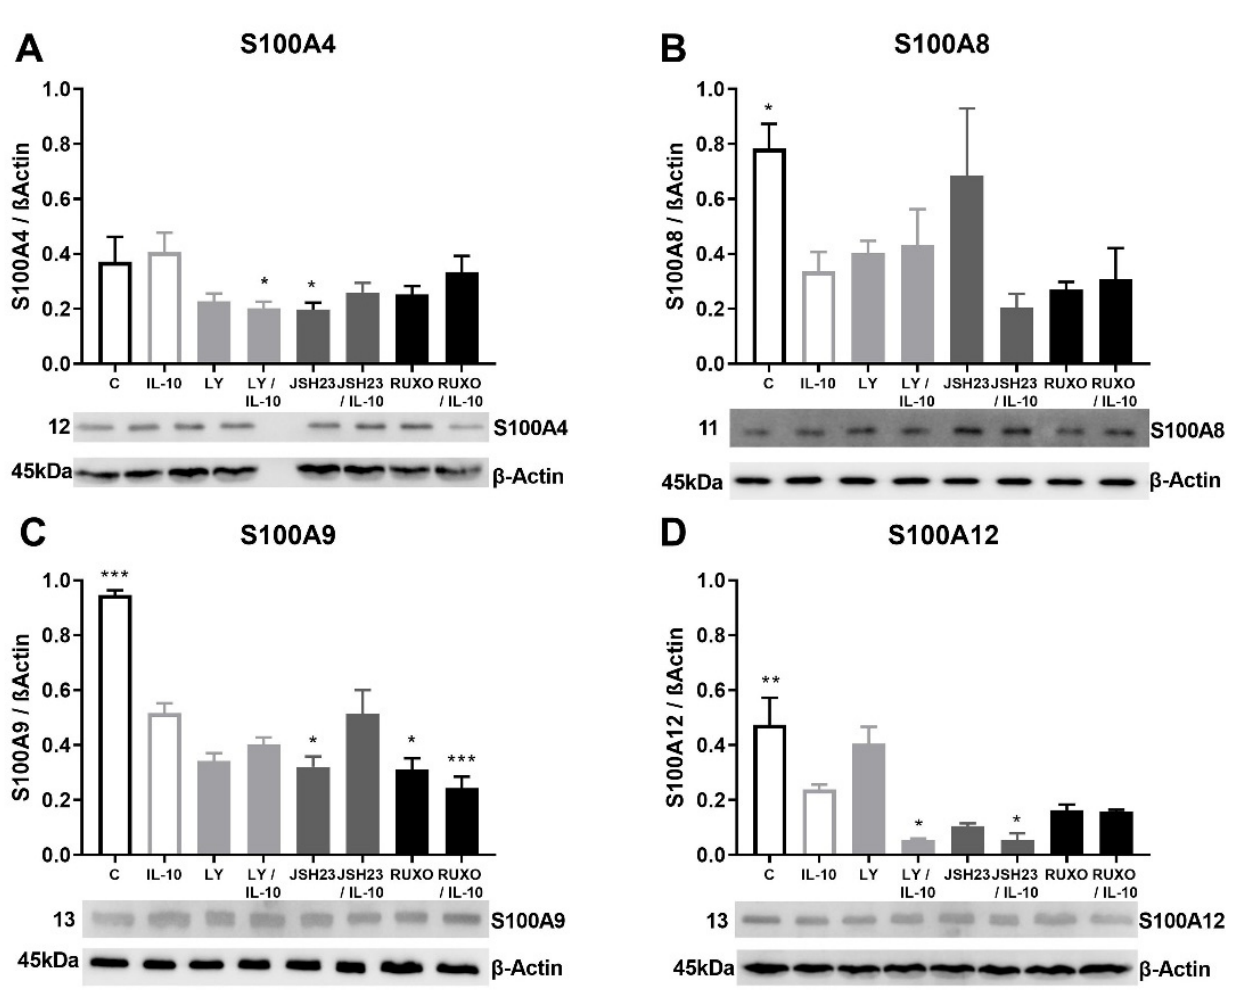
Figure 5. Anti-inflammatory interleukin-10 (IL-10) induction of S100As protein expression in mononuclear cells (MNCs) of peripheral blood of chronic lymphocytic leukemia (CLL). MNCs of CLL were treated 1 h by 30 µ g/mL IL-10 in combination with and without 1.2 nM Ruxolitinib, 10 nM LY294002, and 1.5 nM NF- κ B inhibitor JSH23 and levels of ( A ) S100A4, ( B ) S100A8, ( C ) S100A9, and ( D ) S100A12 were defined. Data results are presented as mean ± SD ( n = 5). * p < 0.05, ** p < 0.01, *** p < 0.001 versus IL-10 treated MNC .